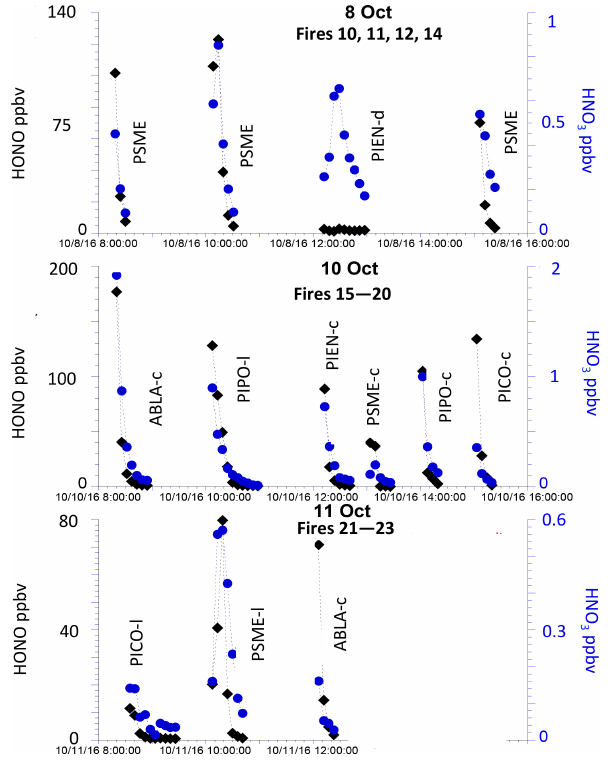
Figure 1. Temporal profile of HONO (black diamond) and HNO 3 (blue circle) concentration measured using the MC–IC method for various stack fires (fire numbers are given in Table 1).